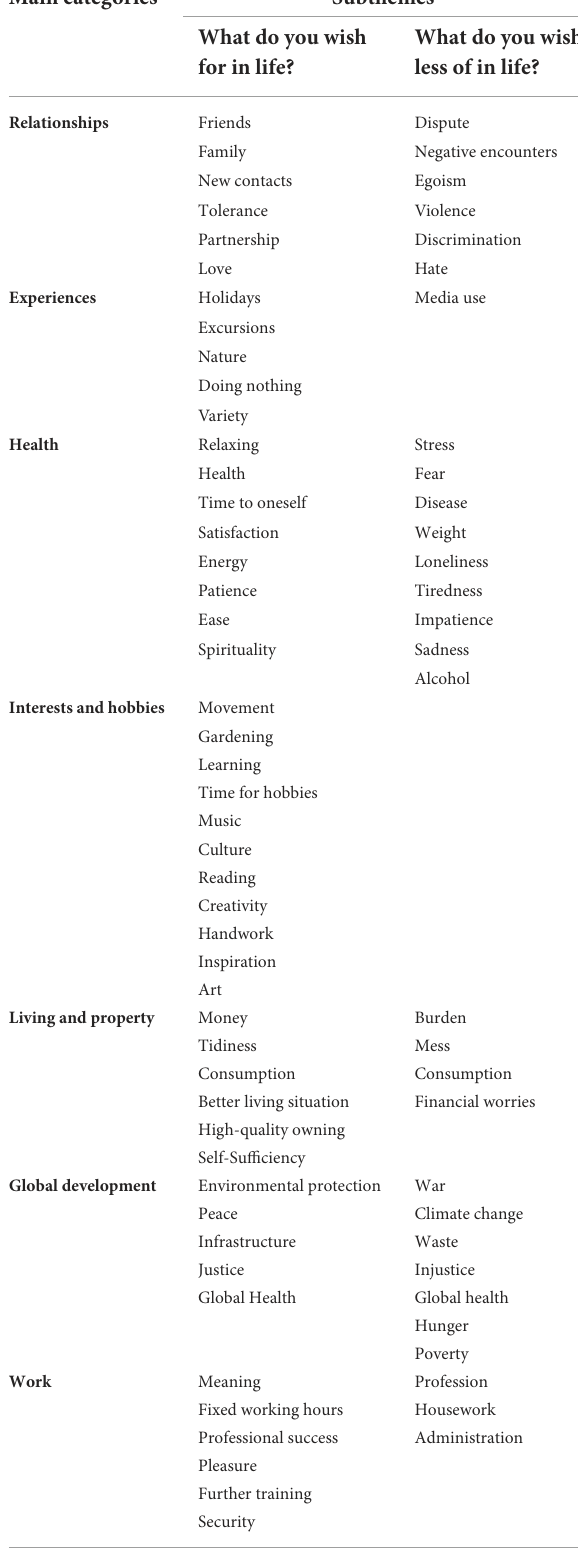
TABLE 2 Overview of main categories and corresponding subthemes identified in reflection exercise 1. Main